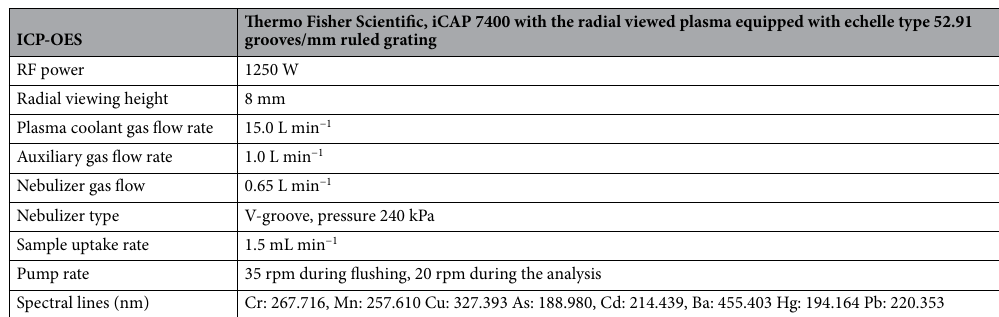
Table 1. ICP-OES operational parameters.